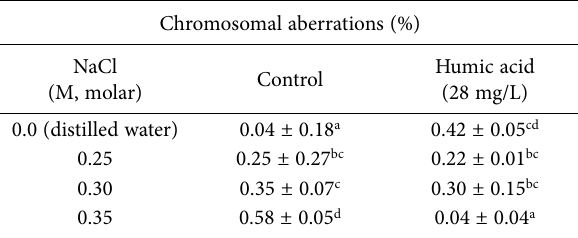
Table 2. Frequency of chromosomal aberrations of barley seeds ger- minated in distilled water and different NaCl concentrations after humic acid pretreatment Chromosomal aberrations (%)